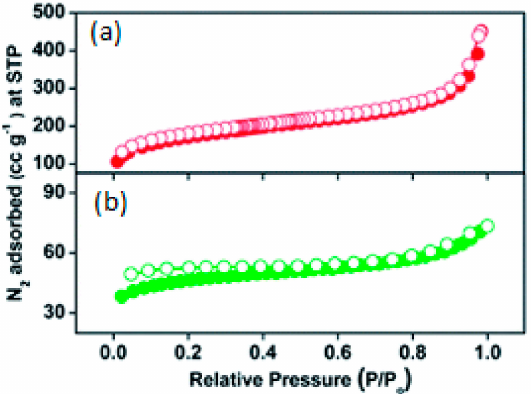
Figure 2. Nitrogen adsorption/desorption isotherms for ( a ) a pure POP and ( b ) a metal-encapsulated POP. Reproduced with permission from [54]. Copyright 2016, the Royal Society of